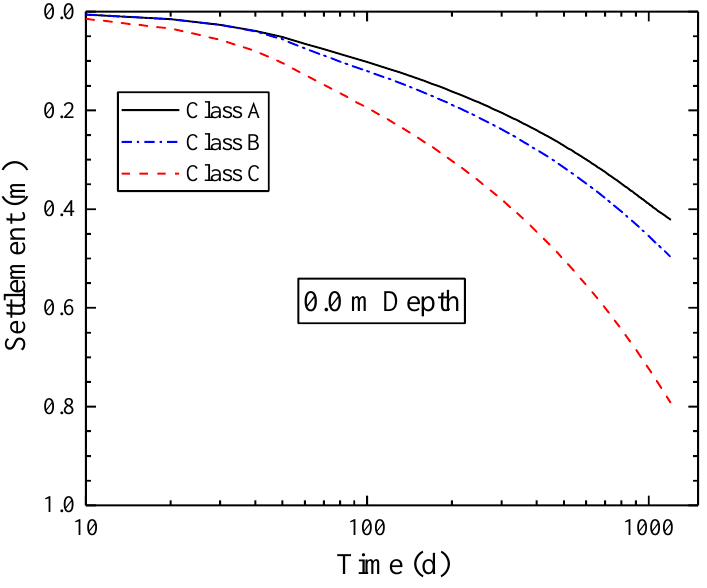
Figure 12. Comparisons of settlement at the top surface. Table 3. Errors between results obtained using nonlinear and constant coefficients at 2.5 m depth.